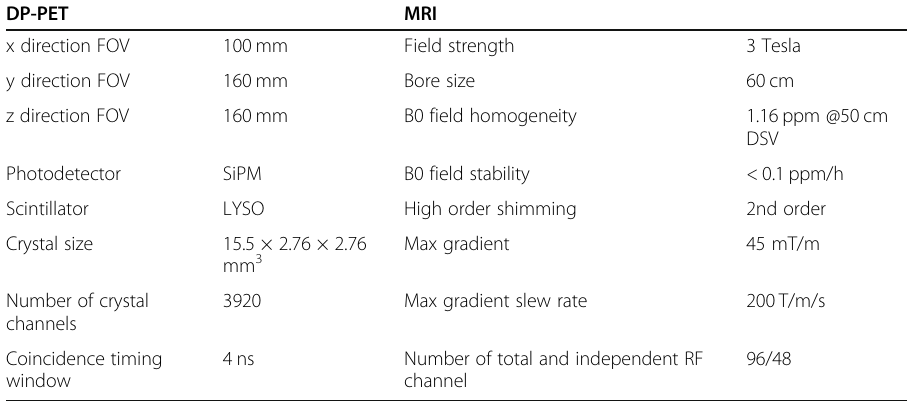
Table 1 Design and performance specifications for PET and MR subsystems DP-PET